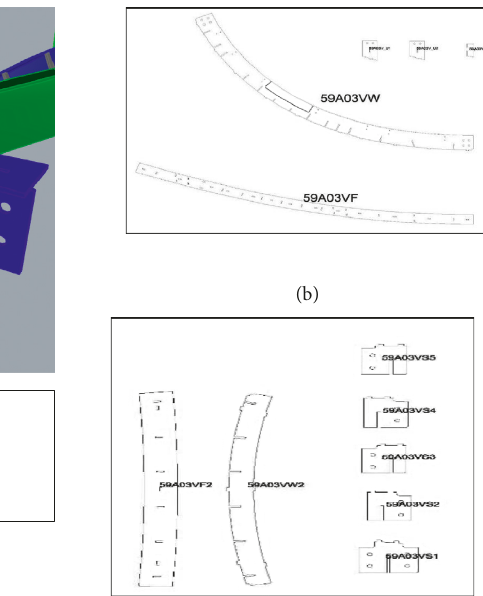
Figure 11: Fabrication information of a CNC